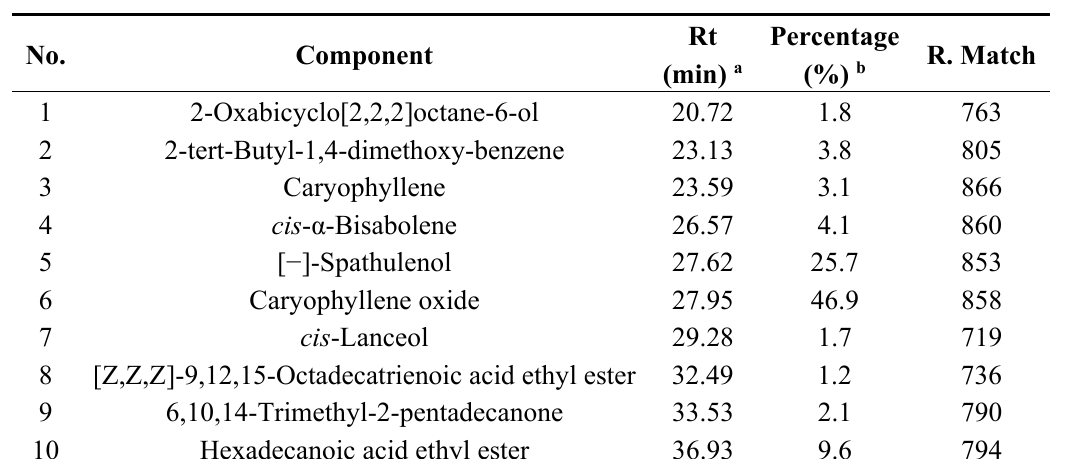
Table 2. Chemical composition of SOE analyzed by